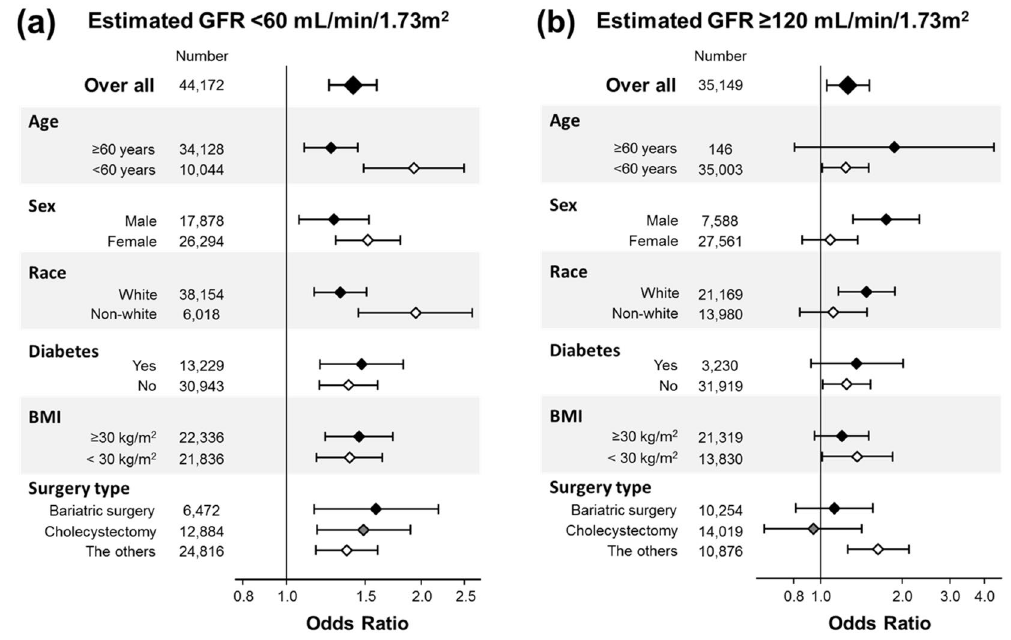
Figure 3. Overall and subgroup analyses of associations between eGFR and risk of post-operative pulmonary complications. Overall and subgroup analyses of associations between eGFR and risk of post-operative pulmonary complications among 425,213 patients who underwent laparoscopic surgery (2005–2013) in the fully adjusted model. Points and bars represent OR estimates and 95% CIs, respectively, (reference: 60 to < 120 mL/min/1.73 m 2 ): ( a ) eGFR < 60 mL/min/1.73 m 2 , ( b ) eGFR ≥ 120 mL/min/1.73 m 2 . Abbreviations: GFR, glomerular filtration rate; BMI, body mass